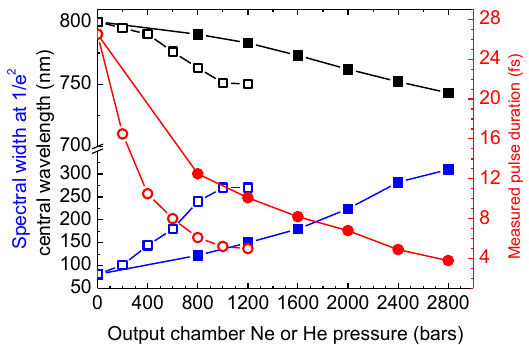
Fig 3. Spectral bandwidth, central wavelength and measured pulse duration evolution as a function of pressure in the case of Ne (open squares and circles respectively) and in the case of He (full squares and circles respectively).